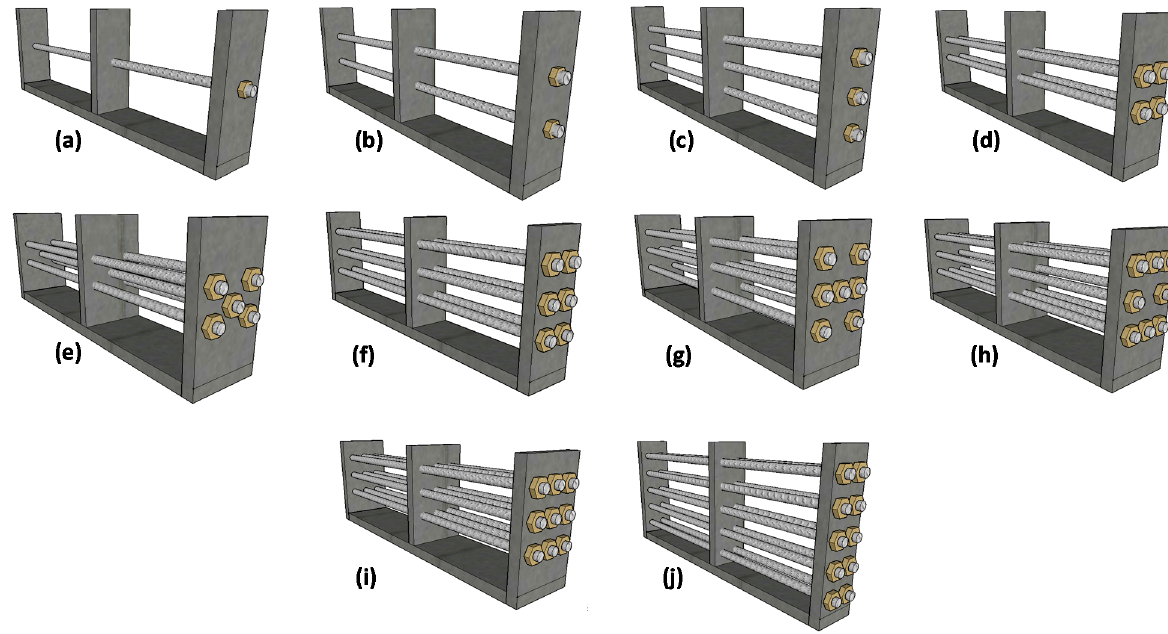
Figure 10. Schematic of SMA-BHD numerical models of variable number of bars: ( a ) one; ( b ) two; ( c ) three; ( d ) four; ( e ) five; ( f ) six; ( g ) seven; ( h ) eight; ( i ) nine; ( j ) ten.